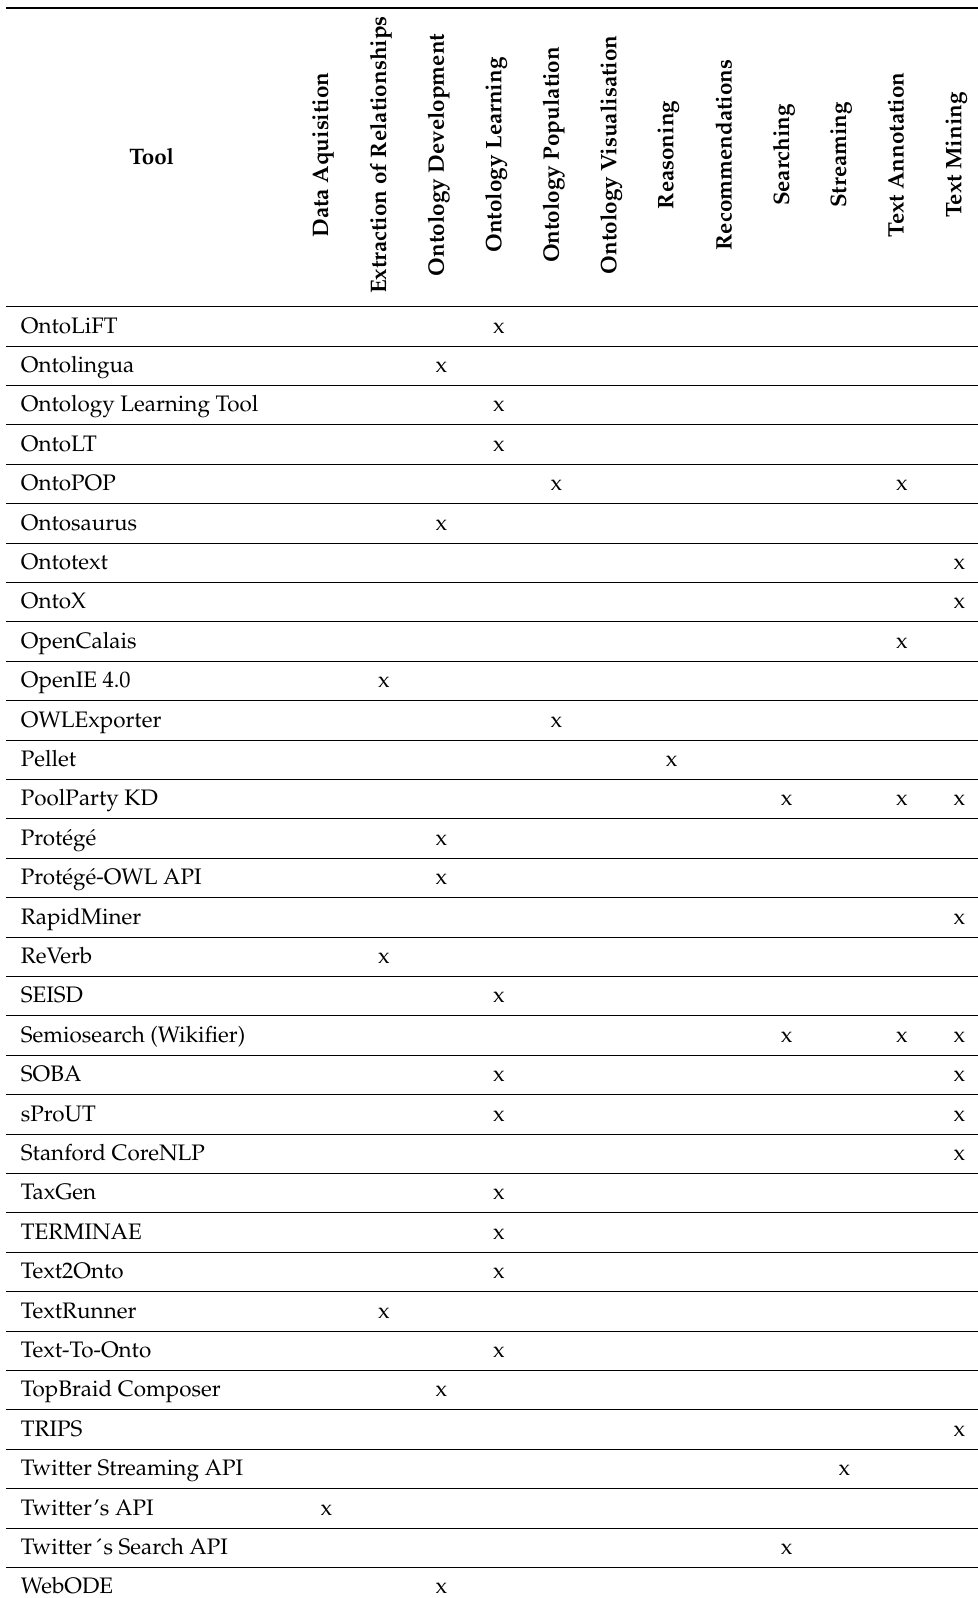
Table 3. Main purpose of the tool (tools